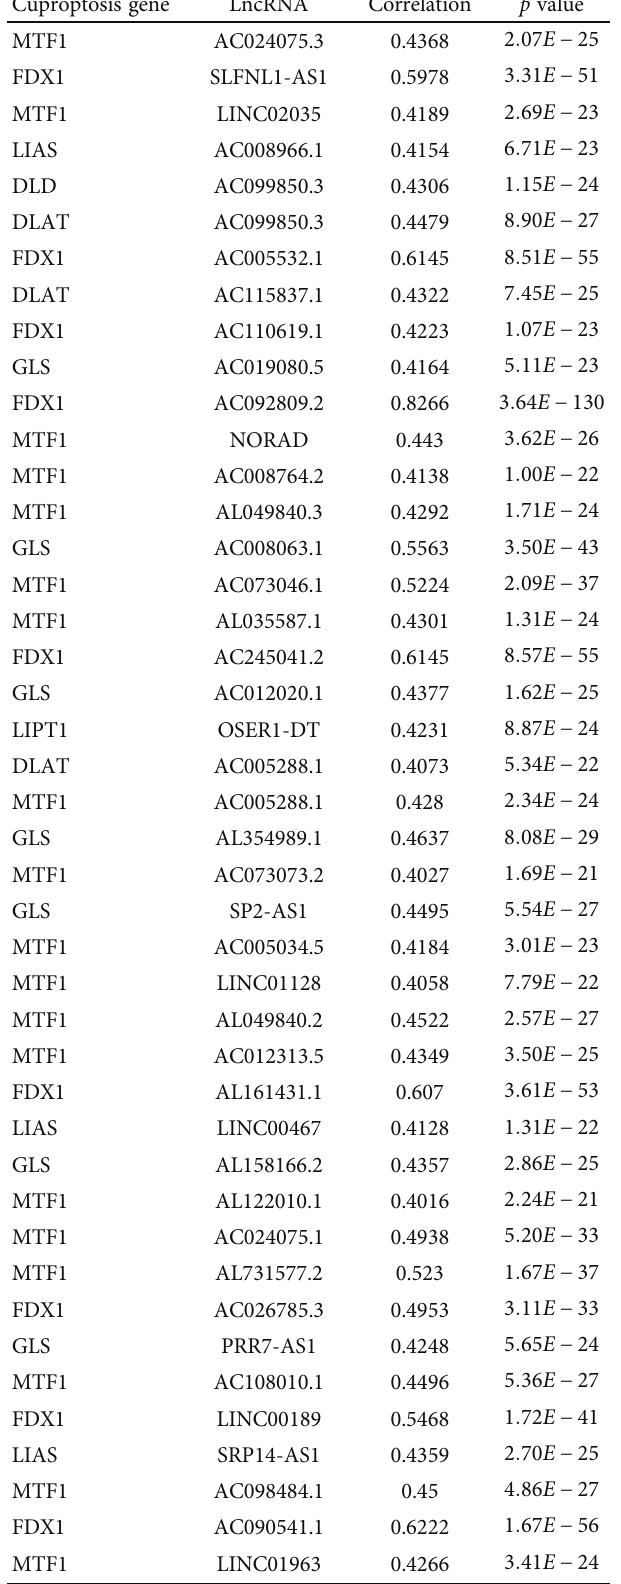
Table 1: Fifty- fi ve cuproptosis-relevant lncRNAs in LUAD. Cuproptosis